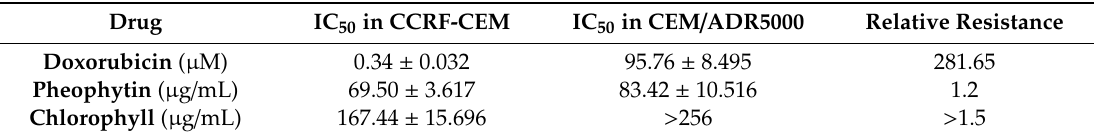
Table 1. The cytotoxicity IC 50 and relative resistance of CCRF-CEM cells and multi-drug resistant CEM / ADR cells against chlorophyll, pheophytin, and doxorubicin (positive control). Data represent means ±